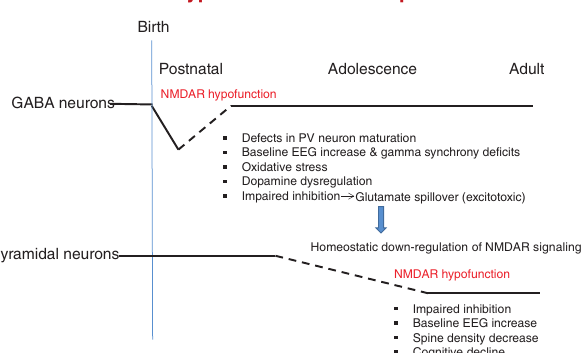
Fig. 3 Dual NMDAR hypofunction model for schizophrenia patho- physiology. Accumulating evidence from genetic and pharmacolo- gical studies lend support for spatially and temporally dissociated NMDAR hypofunction events in schizophrenia pathophysiology. The fi rst NMDAR hypofunction occurs in cortical GABA neurons, including PV neurons, during early postnatal development, impair- ing the cortical circuitry maturation and leading to a variety of fast- spiking neuron-associated abnormalities, including gamma band synchrony de fi cits, oxidative stress increase, dopamine dysregula- tion, and disinhibition of pyramidal neurons. These abnormalities could contribute to the emergence of positive, negative and cognitive symptoms. Moreover, the E/I balance increase eventually elicits glutamate spillover during the prodromal period or later, which could produce a second NMDAR hypofunction in pyramidal neurons in response to low level but cumulative excitotoxicity. NMDAR hypofunction in pyramidal neurons may be responsible for spine density alteration of cortical pyramidal cells, which could also contribute to cognitive and negative symptoms as the disease progresses. Therefore, both types of NMDAR hypofunction may contribute to the schizophrenia pathophysiology. It is unclear when the fi rst NMDAR hypofunction ends and the second hypofunction starts (shown by dotted lines ). The cause of the fi rst NMDAR hypofunction remains to be determined (but see